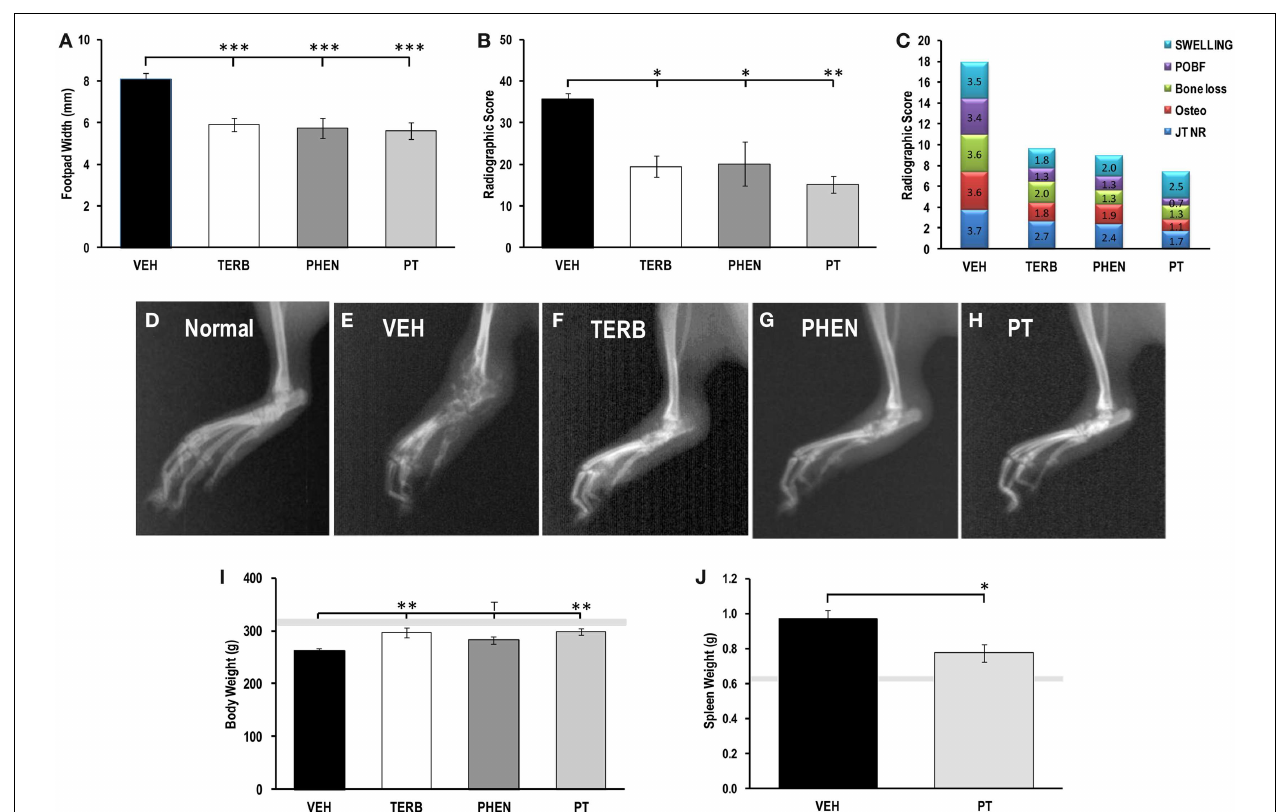
periosteal bone formation (POBF), turquoise. (D) Radiograph of the hind limb representative of normal untreated rats. (E) Radiograph of the hind limb representative of vehicle (VEH)-treated rats. (F) Radiograph of the hind limb representativeTERB-treated rats. (G) Radiograph of the hind limb representative of PHEN-treated rats. (H) Radiograph of the hind limb representative of PT-treated rats. (I) Mean body weights in grams (g) ± SEM for rats treated with vehicle (VEH), terbutaline (TERB), phentolamine (PHEN), or phentolamine and terbutaline (PT).The light gray bar represents the range of body weights for untreated non-arthritic rats. N = 8. ** p < 0.01. (J) Mean spleen weights in grams (g) ± SEM for rats challenged with adjuvant and treated with vehicle (VEH) or phentolamine and terbutaline (PT).The light gray bar represents the range for normal spleen weights of untreated non-arthritic rats. N = 8. * p < 0.05.